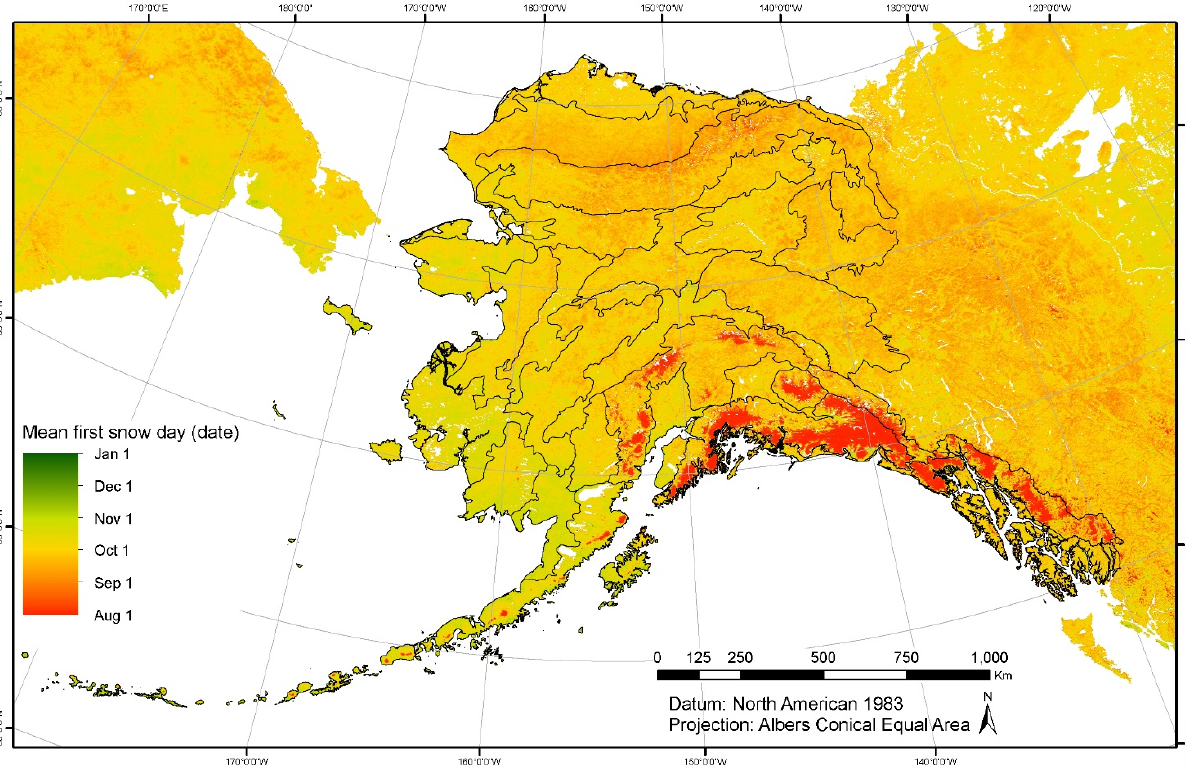
Figure 7. Mean first snow date (FSD) for the full snow season during 2001–2013 snow years with respect to ecoregion [33]. Ecoregion data courtesy of U.S. Geological